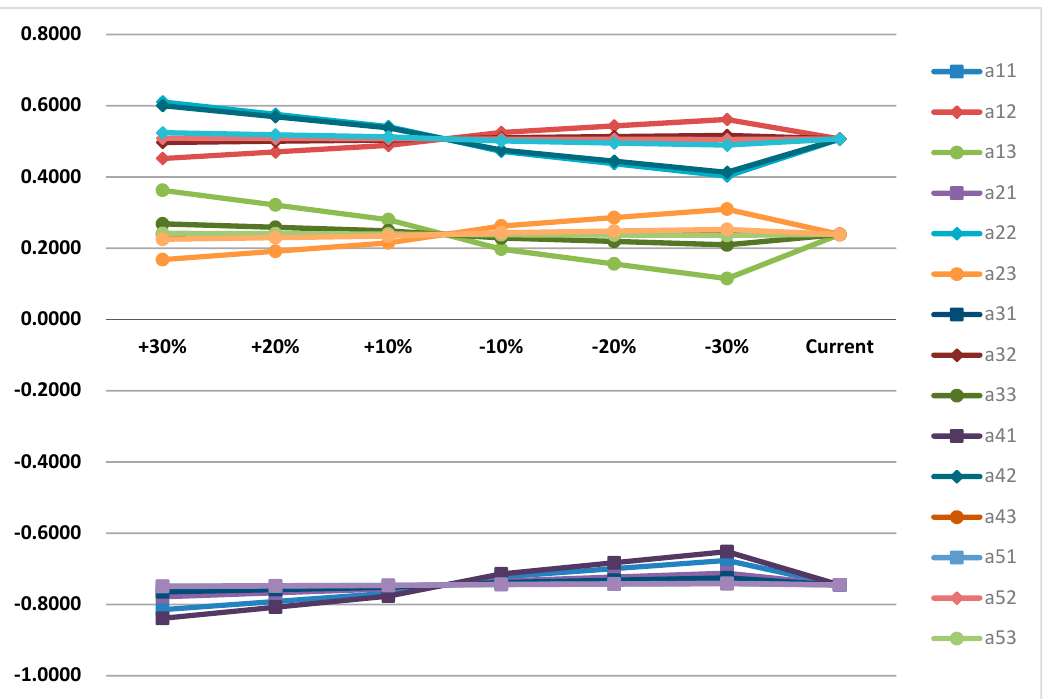
Figure 4. Sensitivity analysis was carried out according to the weight change of each level index.